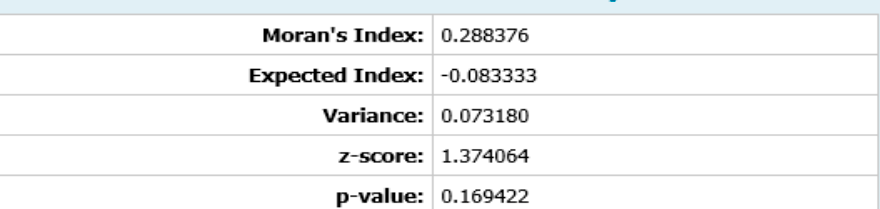
Figure 3. Spatial autocorrelation map showing the spatial distribution of health facilities providing blood group and rhesus type testing in the blood group and rhesus type testing in the UER.